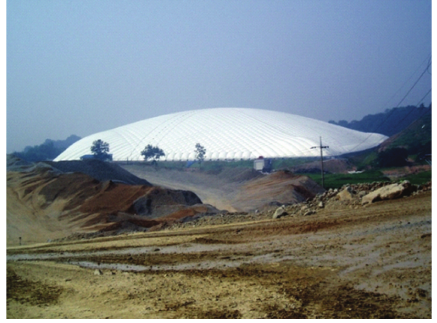
Figure 2: Stadium under inflatable